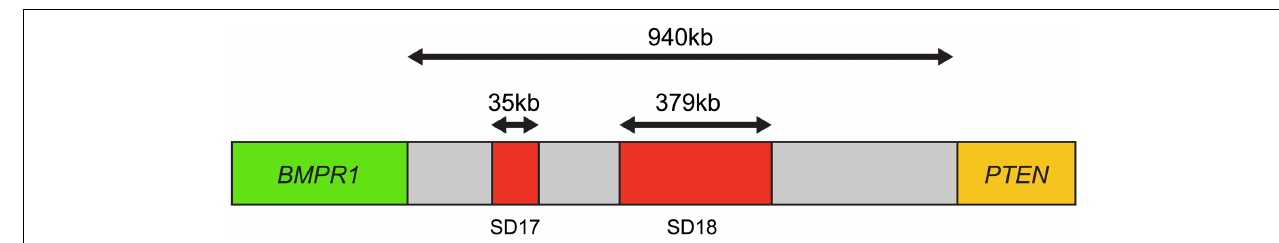
FIGURE 4 | Map of the breakpoint cluster region between BMPR1 and PTEN .The 940-kb interval between BMPR1 and PTEN includes the segmental duplication clusters SD17 and SD18, which are 35kb and 379kb in